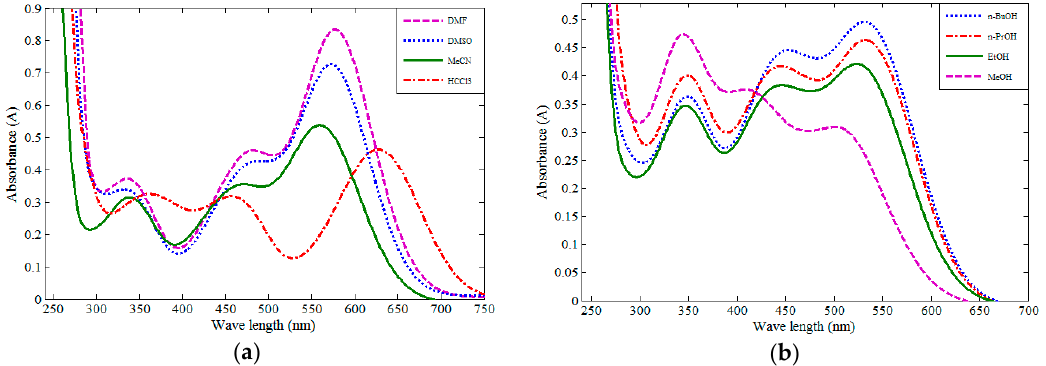
Figure 4. Electronic spectra of 2.0 × 10 − 5 M compound 4f : ( a ) In DMSO, MeCN, HCCl 3 and DMF; ( b ) In n -butanol, n -propanol, ethanol and methanol.